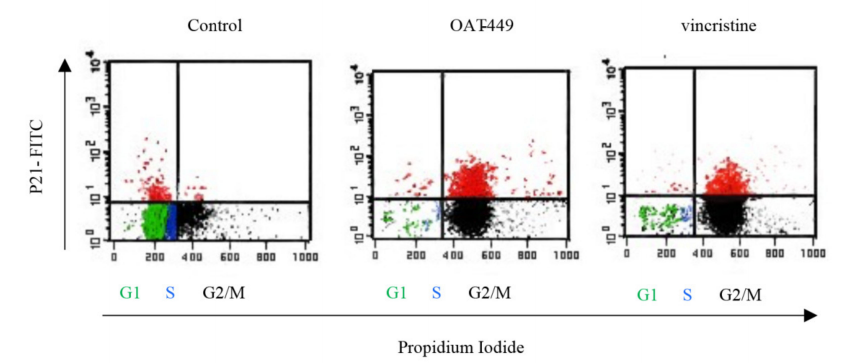
Figure 8. Increased expression of p21 in cells exhibiting G2 / M phase arrest. HT-29 cells were treated for 24 h with 30 nM of OAT-449, vincristine or DMSO as a control. Cells were stained with anti-p21-FITC antibody and propidium iodide, with 10,000 cells analyzed per sample. Plots shown are representative of at least three independent experiments.